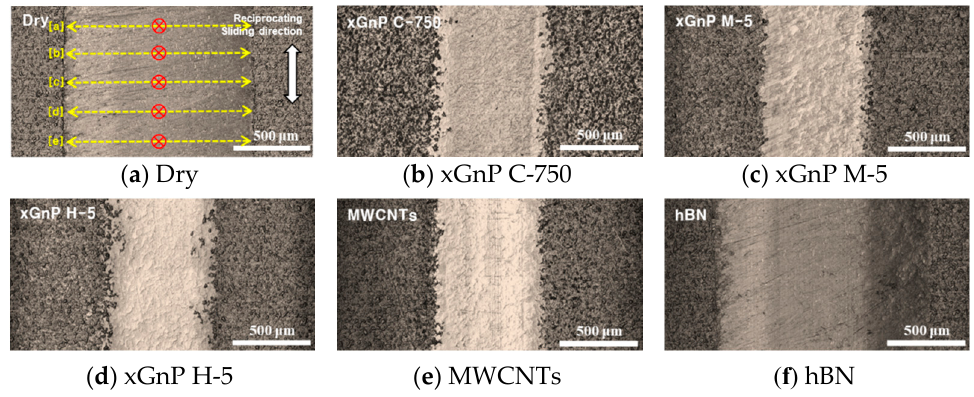
Figure 5. Optical microscopic images of MD-CFRP after the ball on plate test.